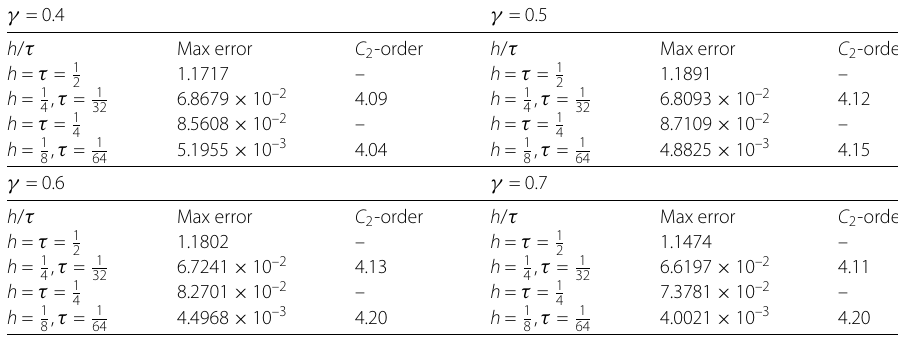
Table 11 C 2 -order of convergence of HEGM for Example 2 and different γ ’s γ = 0.4